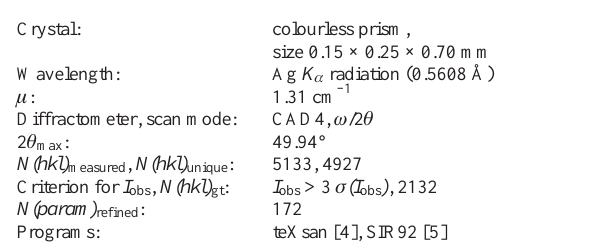
Table 1. Data collection and handling.